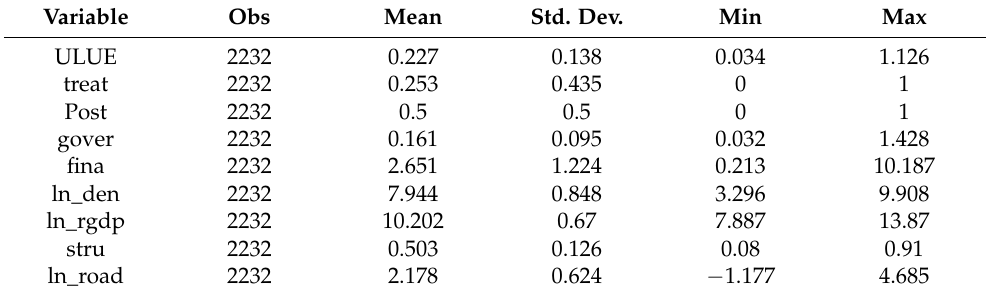
Table 3. Descriptive